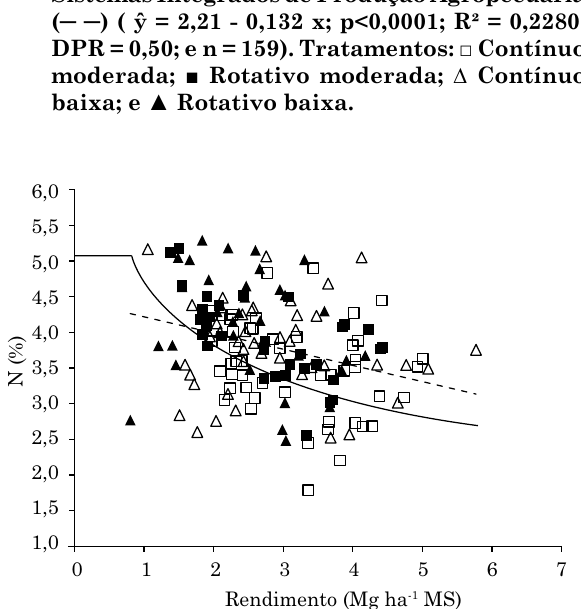
Figura 4. Curva de diluição de nitrogênio (-) e relação entre teor de n e rendimento da cultura de soja fertilizada pela adubação sistêmica em Sistemas Integrados de produção agropecuária (─ ─) (ŷ = 4,6 - 0,288 x; p<0,0001; R² = 0,1735; DPR = 0,65; n = 190). Tratamentos: □ Contínuo moderada; ■ Rotativo moderada; ∆ Contínuo baixa; e ▲ Rotativo